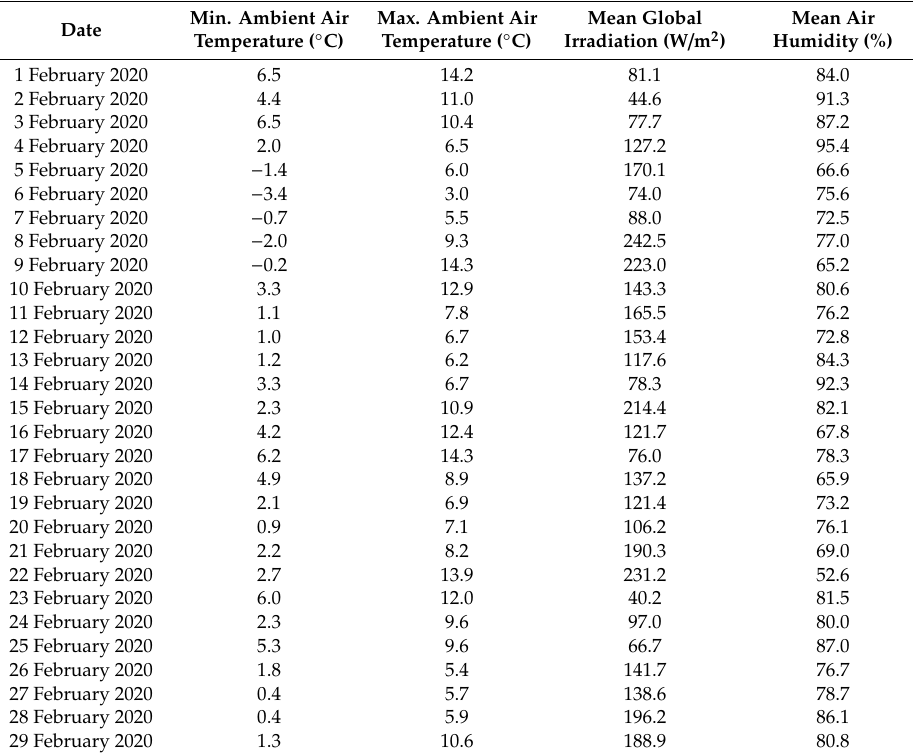
Table A3. Measured boundary conditions in February 2020.